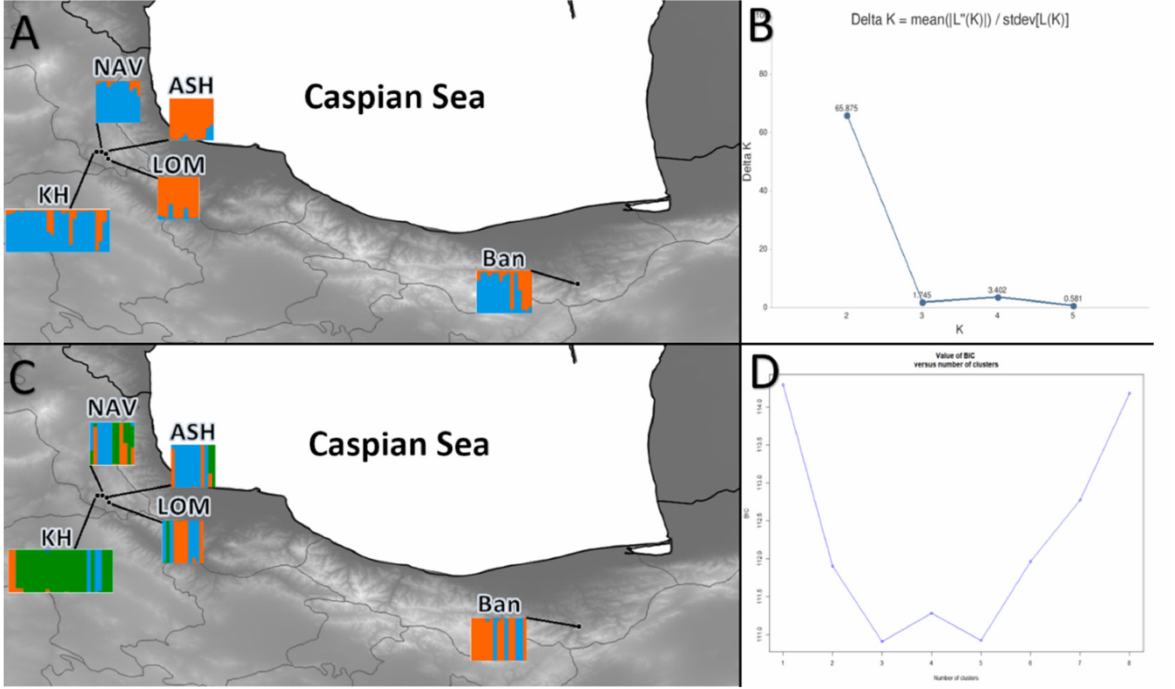
Figure 2. ( A ): Results from STRUCTURE for K = 2 for populations of Sorbus aucuparia , ( B ): the optimal number of clusters (K) for STRUCTURE estimated by method from Evanno et al. (2005) [50], ( C ): results from DAPC for K = 3, ( D ): best number of cluster determined by find cluster in R. For abbreviations of the populations, see Table